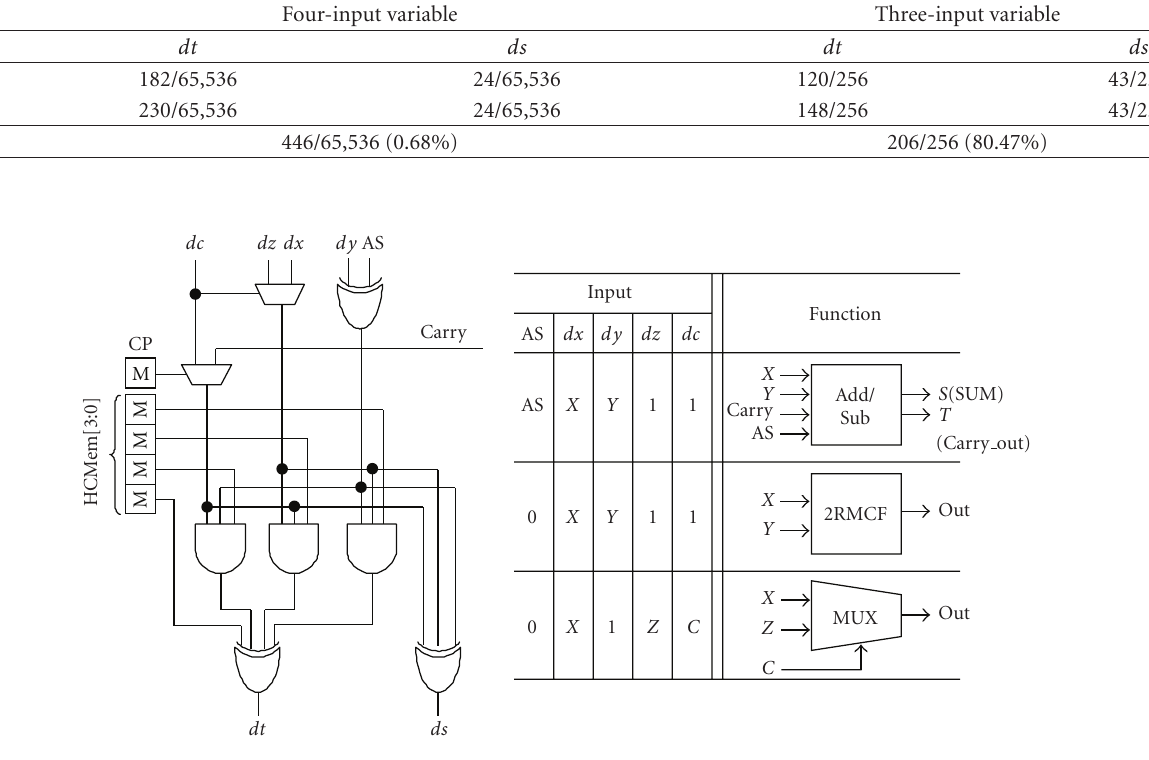
Figure 4: Components and functions of a